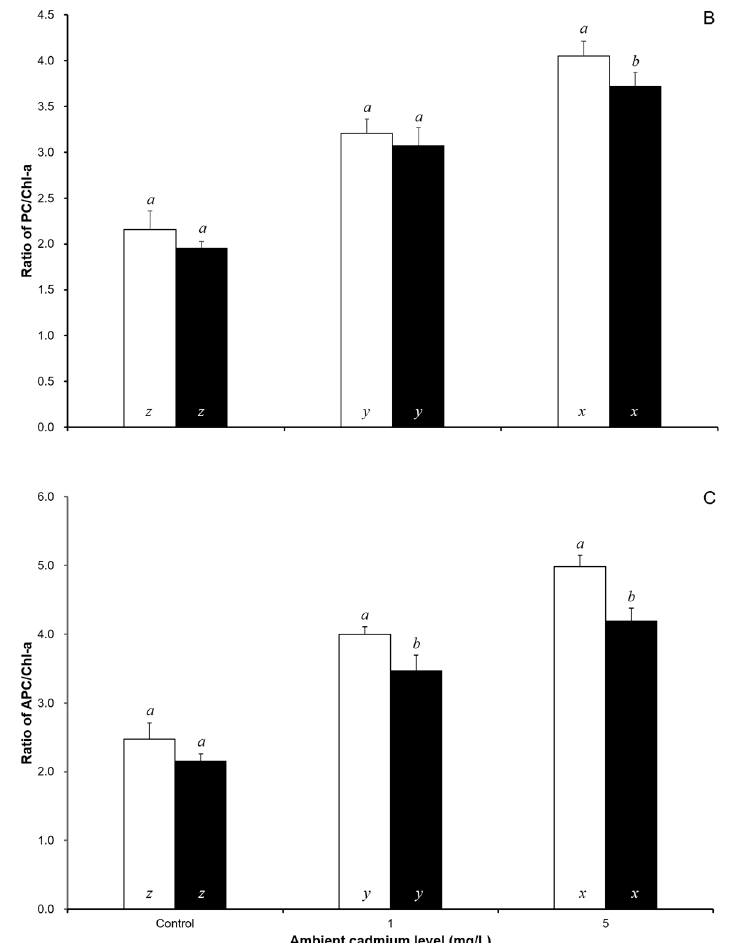
Figure 3. The ratios of PE / Chl-a ( A ), PC / Chl-a ( B ), and APC / Chl-a ( C ), in S.suiae, following 24 h exposure with control, 1, and 5 Cd 2 + mg / L. Data in the same ambient cadmium level having di ff erent letters ( a and b ) are significantly di ff erent ( p < 0.05) between light and dark bottles, and data in the same light or dark bottles having di ff erent letters ( x , y and z ) are significantly di ff erent ( p < 0.05) among di ff erent ambient cadmium levels; Chl-a—chlorophyll a; PE—phycoerythrin; PC—phycocyanin; APC—allophycocyanin.